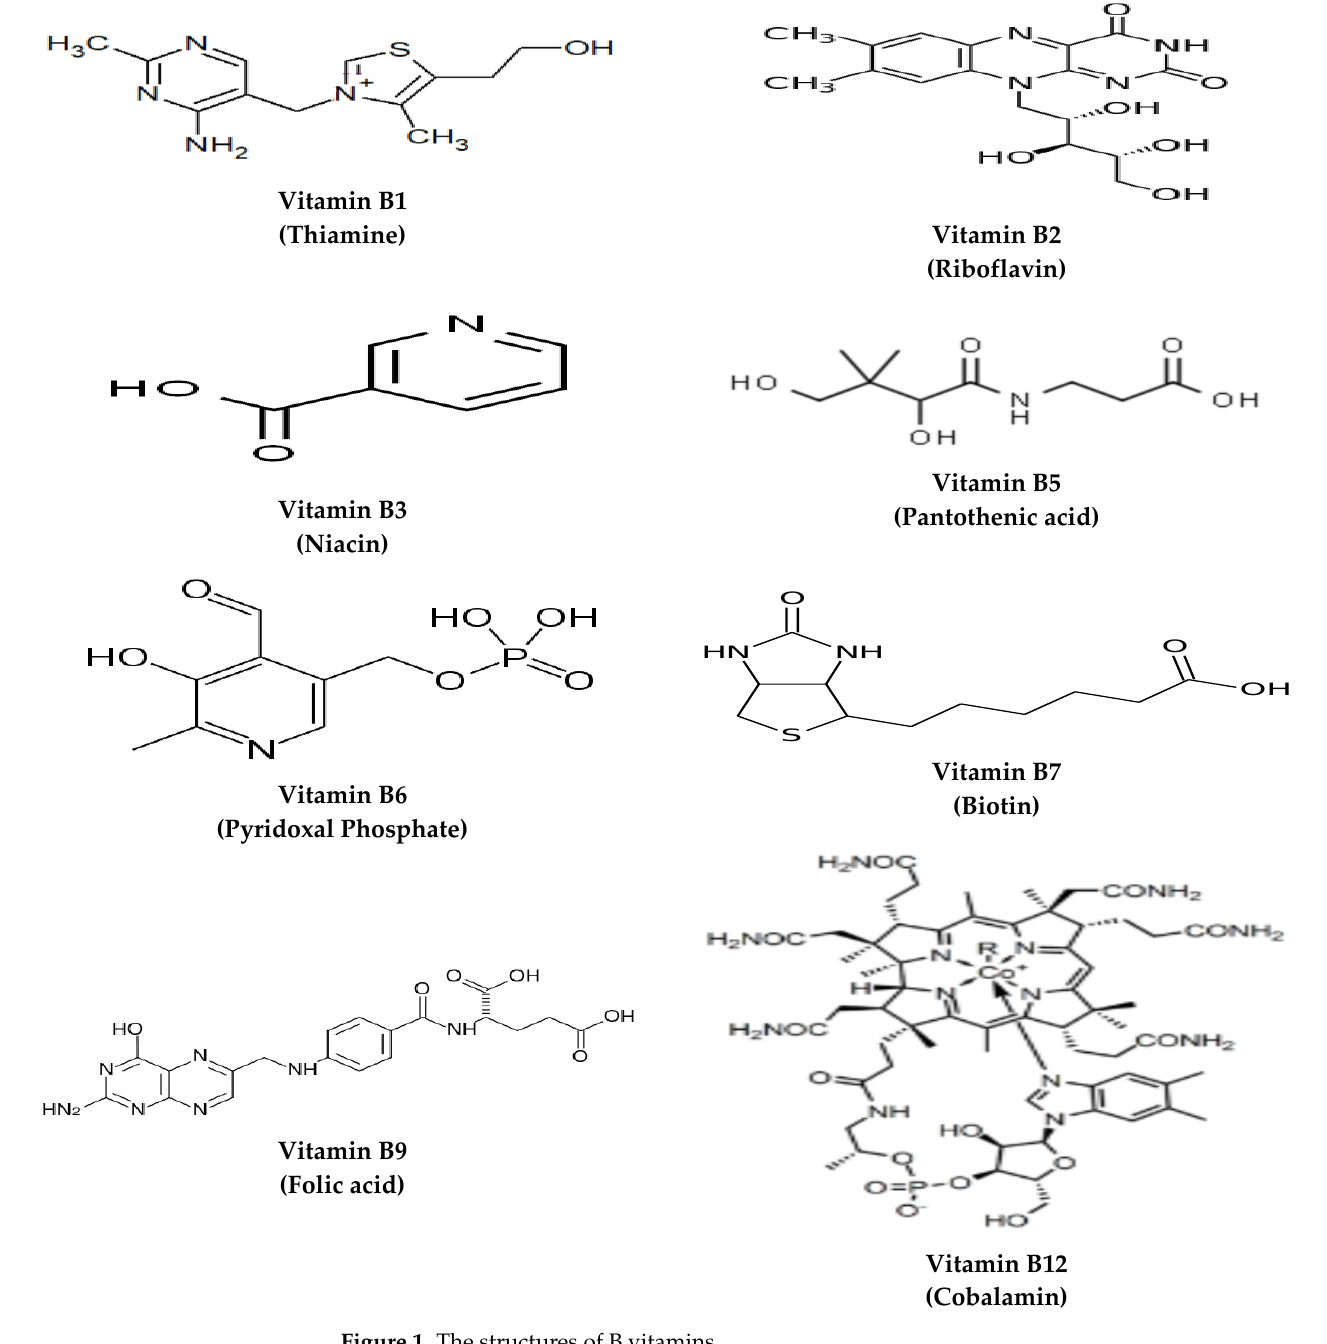
Figure 1. The structures of B vitamins.